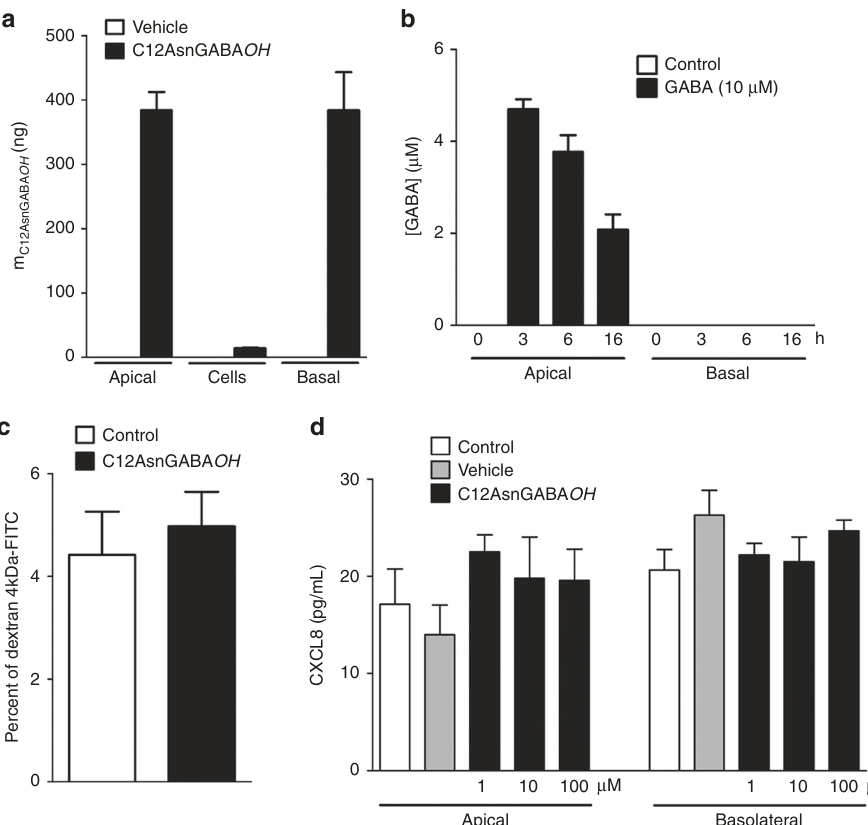
Fig. 6 C12AsnGABA OH crosses the epithelial barrier without modifying epithelial cell physiology. Caco-2 cells were cultivated into transwell chambers. After 24-h treatment with C12AsnGABA OH (800 ng) at the apical side, C12AsnGABA OH was quanti fi ed inside the cells and both the apical and basolateral compartments by LC-MS/MS ( a ); data are represented as mean ± SEM, n = 3 experiments of three wells per condition. Quanti fi cation of GABA concentration at the apical and basolateral compartments 3, 6, or 16 h after loading (black bars) or not (white bars) Caco-2 cells with 800 ng of GABA at the apical site ( b ); n = 3 experiments of three wells per condition. Paracellular permeability assessed by the passage of FITC-dextran loaded at the apical side ( c ) and CXCL8 secretion assessed by ELISA ( d ) were determined after 24-h treatment of Caco-2 cells at the apical side with C12AsnGABA OH (10 µ M); data are represented as mean ± SEM, n = 3 experiments of three wells per condition. Statistical analysis was performed using Kruskal – Wallis